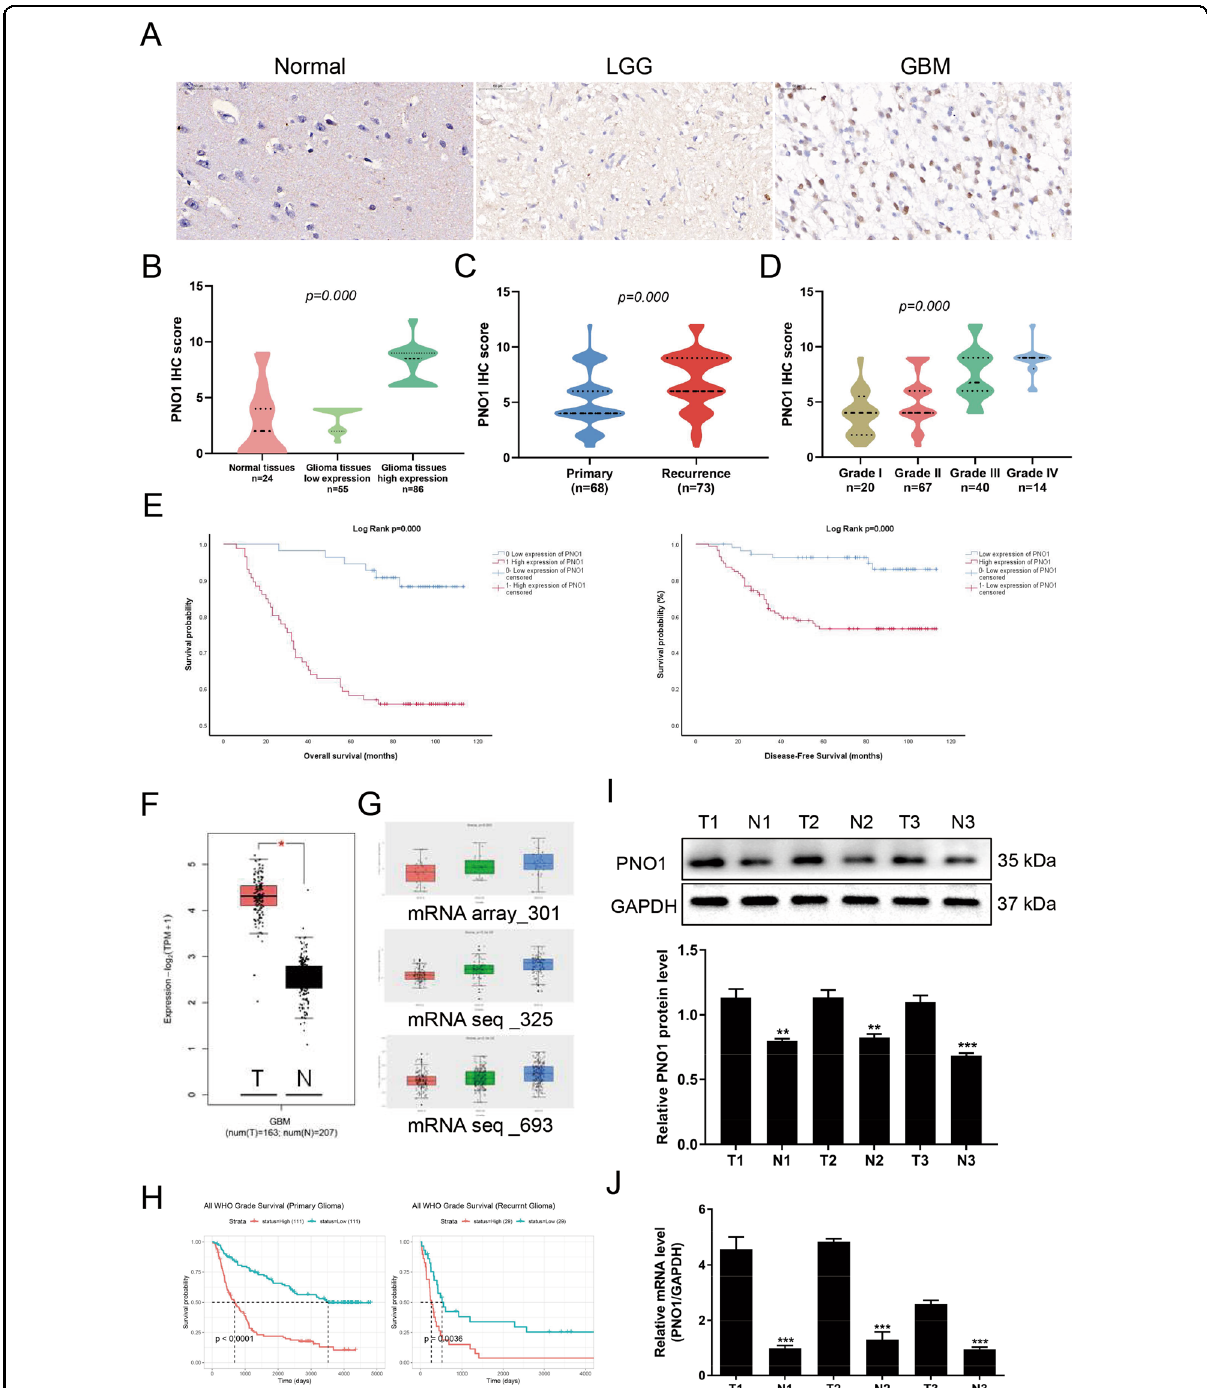
Fig. 2 PNO1 is a speci fi c prognostic biomarker in glioma tissues. A Representative images of normal tissues and glioma tissues showing PNO1 expression (50µm). B PNO1 protein levels in 141 glioma tissues (55 LGG and 86 GBM) and 24 normal tissues were determined by IHC. C Correlation analysis between the PNO1 IHC score and tumor recurrence. D Correlation analysis between the PNO1 IHC score and tumor Grade. E Kaplan – Meier survival curve analysis showing the correlation between the PNO1 IHC score and OS (left) and DFS (right) in glioma patients. F PNO1 mRNA expression in 163 GBM tissues and 207 normal tissues were analyzed using online glioma database from GEPIA2. *P < 0.05. G Correlation analysis between the PNO1 mRNA expression and tumor Grade using online glioma database from CGGA. H Kaplan – Meier survival curve analysis showing the correlation between the PNO1 mRNA expression and OS in primary or recurrent glioma patients using online glioma database from CGGA. Western Blotting ( I ) and RT-PCR ( J ) showing PNO1 protein and mRNA levels between three GBM tissues (T) and three normal tissues (N). n = 3, *P < 0.05, ** P <0.01, *** P <